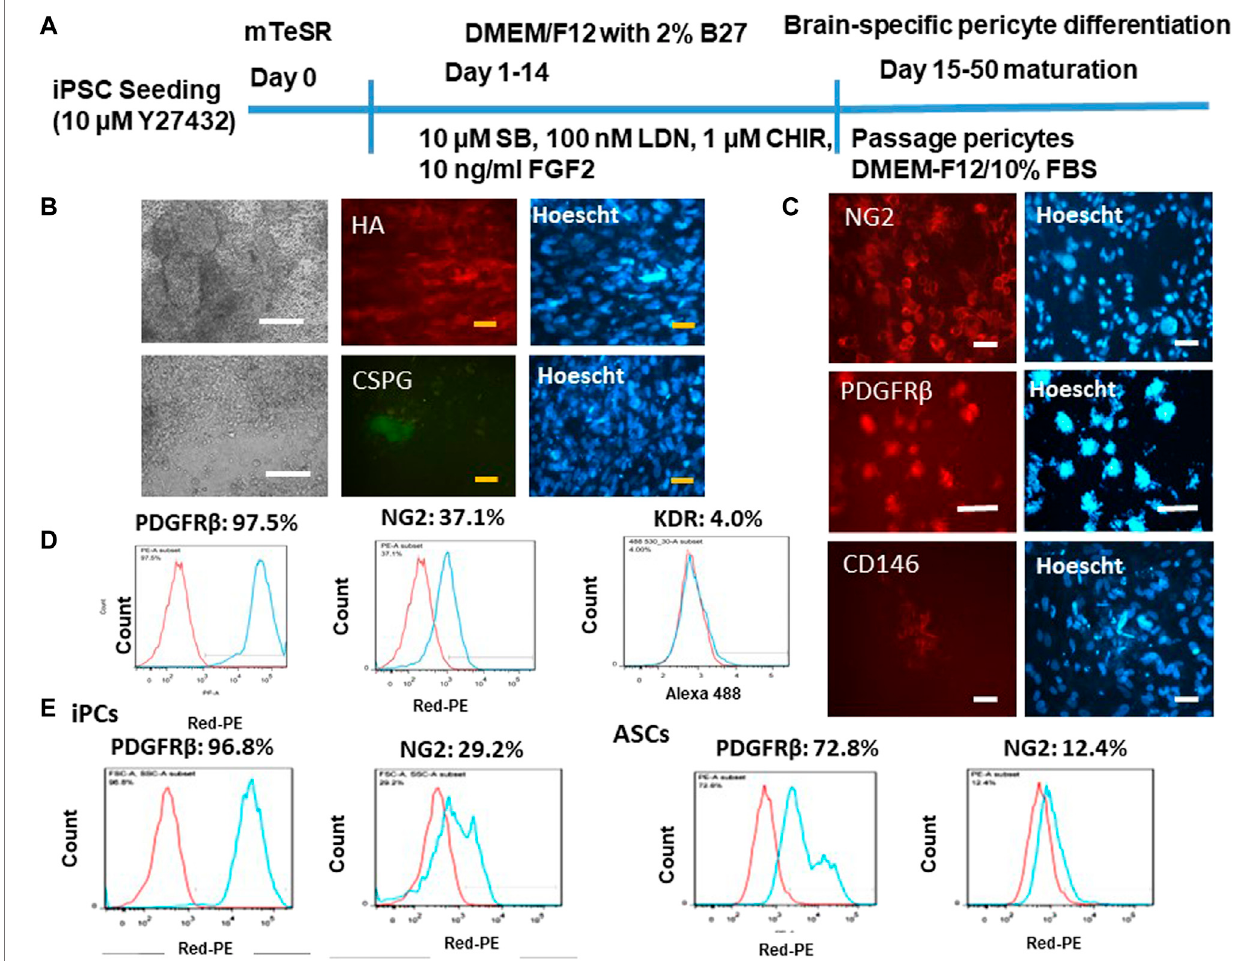
FIGURE 1 | Characterization of brain-speci fi c pericytes derived from iPSK3 cells (iPCs). (A) Schematic of protocol for differentiation of brain pericytes from iPSK3cells;SB:SB431542;LDN:LDN193189;andCHIR:CHIR99021. (B) Cellmorphologyand fl uorescentimagesforextracellularmatrixproteinshyaluronicacid(HA) and chondroitinsulfate proteoglycan (CSPG) onday 25pericytes. Whitescale bar:200 μ m,yellow scalebar: 50 µm. (C) Expression ofpericytes receptor markers NG2, PDGFR β , and CD146. Cell nuclei were counterstained with Hoescht. Scale bar: 50 µm. (D) Flow cytometry histograms for pericyte marker NG2, PDGFR β , and mesodermprogenitormarkerKDR. (E) Flowcytometryhistogramsforday25differentiatedpericytescomparedwithhumanadipose-derivedstemcells(ASCs).Redline: negative control; blue line: marker of interest.